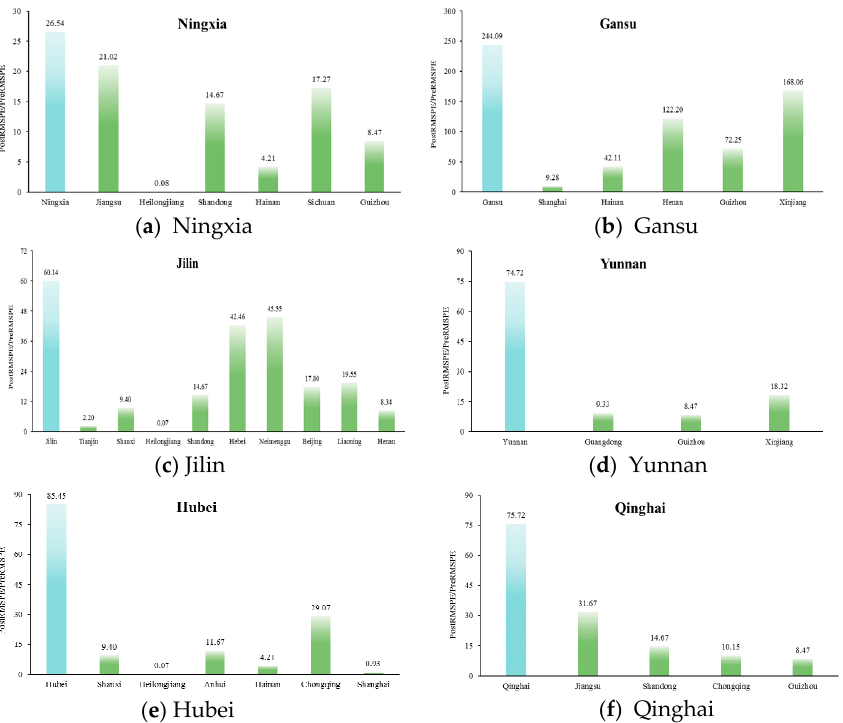
Figure 5. Distributions of the ratio of RMSPE before and after TPEFAP for six provinces.